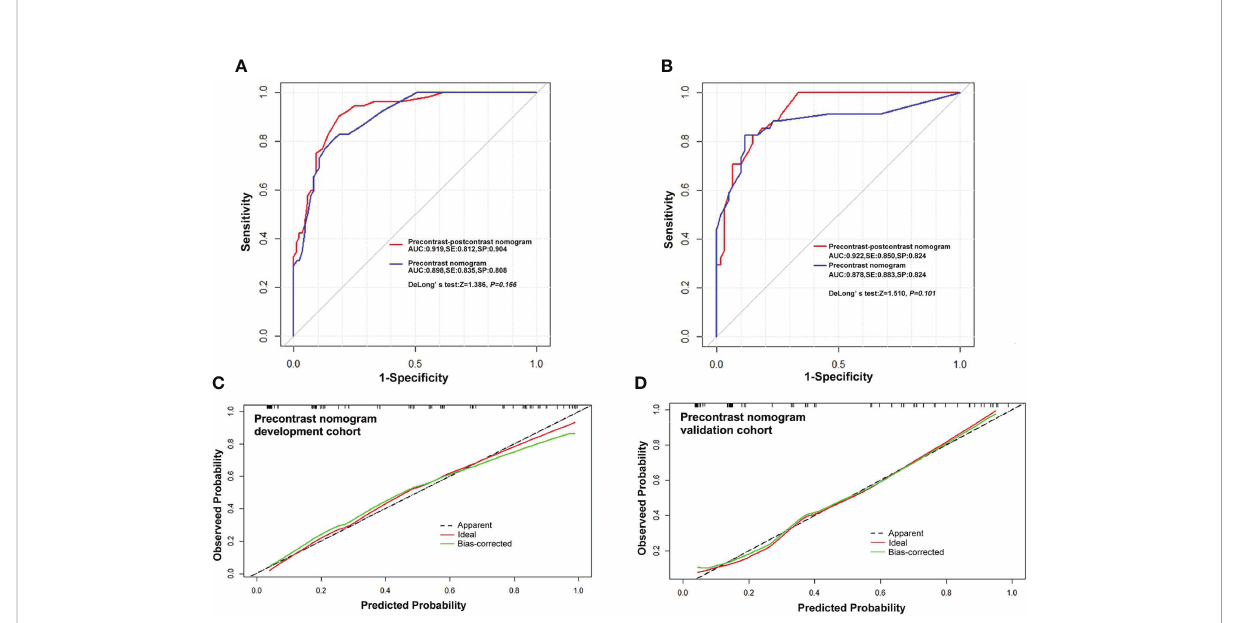
FIGURE 3 Receiver operating characteristic curves and calibration curves. (A, B) ROC curves for predicting high-grade meningiomas in the development and validation cohort with the precontrast – postcontrast model and precontrast model, respectively. (C, D) Curves of the calibration analysis for the precontrast model in the development and validation cohorts, respectively. The calibration curves of the precontrast – postcontrast model also showed a satisfactory calibration performance in both the development and validation cohorts (see Supplementary Material). ROC, receiver operating characteristic curve; AUC, area under ROC curve; SE, sensitivity; SP, speci fi city.